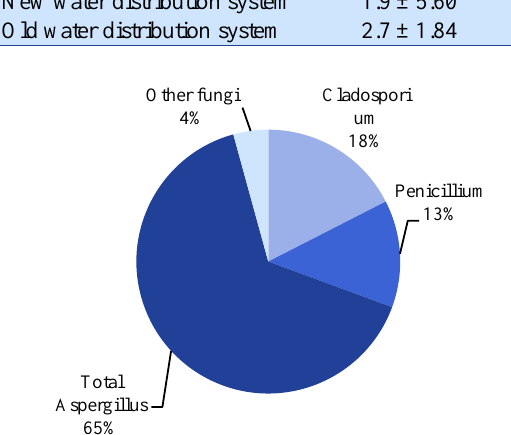
Figure 5. Percentage of fungi isolated in new water distribution